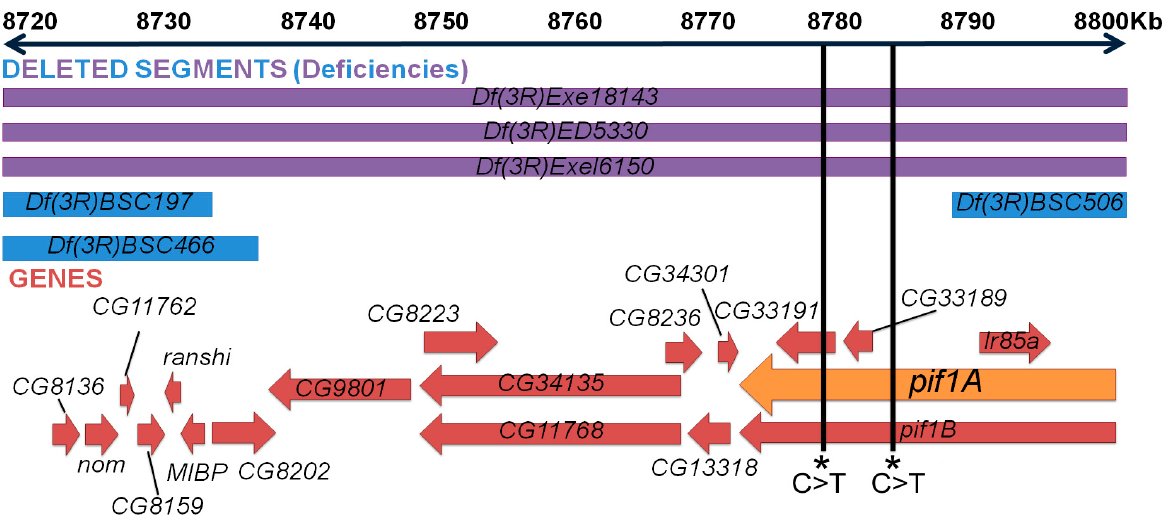
Figure 7. Identifying candidate genes for Z3-5009 phenotype. Cytological map of area-of-interest (chromosome 3R) derived by deficiency crosses. Top blue and purple rectangles refer to genetic regions that the deficiency lines are lacking—the sequences deleted extend beyond the constraints of this figure. Purple represents deficiency lines that failed to complement the mutant phenotype; blue represents lines that complemented (are fertile). In the lower portion, red arrows represent genes in the area-of-interest, and the orange arrow represents the gene thought to be responsible, Pif1A . Three deficiencies failed to complement Z3-5009 overlap in the region of